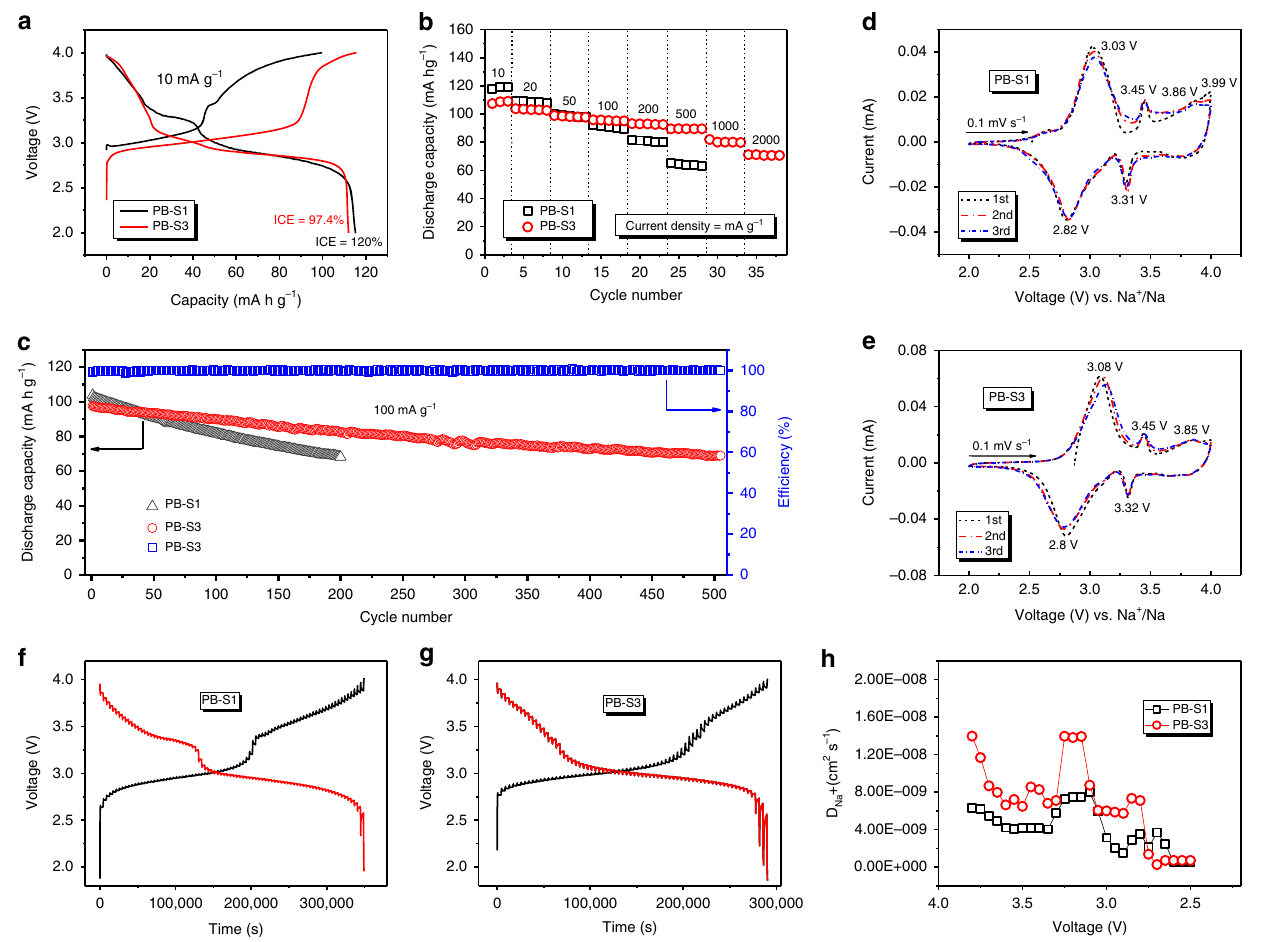
Fig. 3 Electrochemical properties of cubic PB-S1 and rhombohedral PB-S3 samples. The ( a ) initial charge – discharge curves, ( b ) rate and ( c ) cycling performance, ( d , e ) CV curves, ( f , g ) GITT curves, and ( h ) calculated D Na + during the discharge process of the PB-S1 and PB-S3 transition from the rhombohedral to the cubic structure. Fur- shows the re fl ection planes of (200), (220), and (400) of in situ thermore, the peak shifting stopped around 3.2 V and then slightly PXRD patterns of the initial cycle of cubic PB-S1 sample, all the shifted back to lower angles when keep charging over 3.2 V until peaks shifted toward higher angles during charge process but they 4.0 V. This was caused by the phase transition from a cubic to a could not return to original positions after discharging, indicating tetragonal phase (P4/mmm space group) due to more Na + being the irreversible lattice shrink occurred after Na + extraction, the result is consistent with our previous work 20 . Two peaks were extracted and the lattice was expanded 13 . For comparison, the observed at the end of discharging process of (200) and (400) simulated PXRD data from three phases are illustrated in Fig. 5b, re fl ections, which might due to part of Na + from anode side which is consistent with our selected in situ synchrotron PXRD inserting into cathode side and a mixture of cubic and rhombo- results (Fig. 5a). The three-phase transitions from rhombohedral, hedral phase was formed. In comparison, the fi rst two cycles were cubic, and tetragonal for PB-S3 sample were also con fi rmed by recorded for rhombohedral PB-S3 sample, three representative selected Le Bail fi tted PXRD patterns from pristine, 3.2 and 4.0 V re fl ection of planes (012), (110)/(104), and (024) are illustrated in charging states, as shown in Fig. 5d, e, f, respectively. The discharge Fig. 4c. The peak shift for all peaks is highly reversible in two cycles, indicating the rhombohedral framework could be well restored after Na + extraction/insertions. The peak broadening of (110)/(104) might be caused by a slightly changed cell orientation or internal strain in the cell cathode during the measurement. The PXRD patterns of electrode of pristine and discharged to 2.0 V clearly a rhombohedral phase could be observed from double peaks around 24° (Fig. 5c). In terms of obvious peaks of (012) and (024) in synchrotron in situ PXRD data (Fig. 4c), during the fi rst cycle, the peaks shifted towards higher angles at the onset of charging process, which demonstrate that the lattice parameters were reduced after Na + extracted from the structure. After charged to 3.2 V, the (110) and (104) peaks merged together with the phase